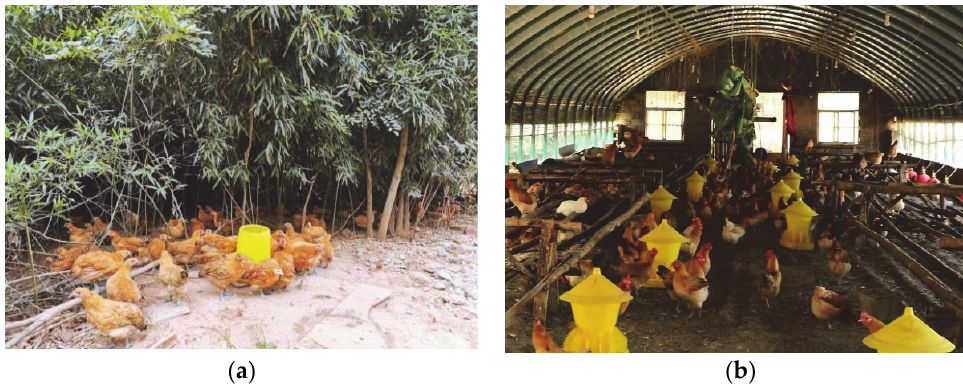
Figure 2. Raising laying hens in a bamboo forest. ( a ) Laying hens resting and drinking in a bamboo forest; ( b ) A shed with perches, feeders and drinkers. Note: ( a ) taken by Shaocong Yan; ( b ) from Lujiang News Network: http://www.ahljnews.com/8229381/33969499.html (accessed on 15 June 2022).